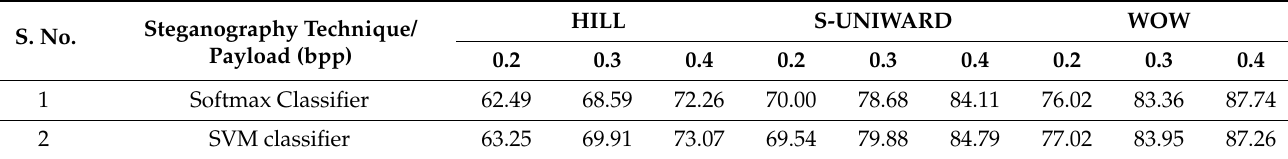
Table 3. Performance analysis of the softmax and SVM classifier.